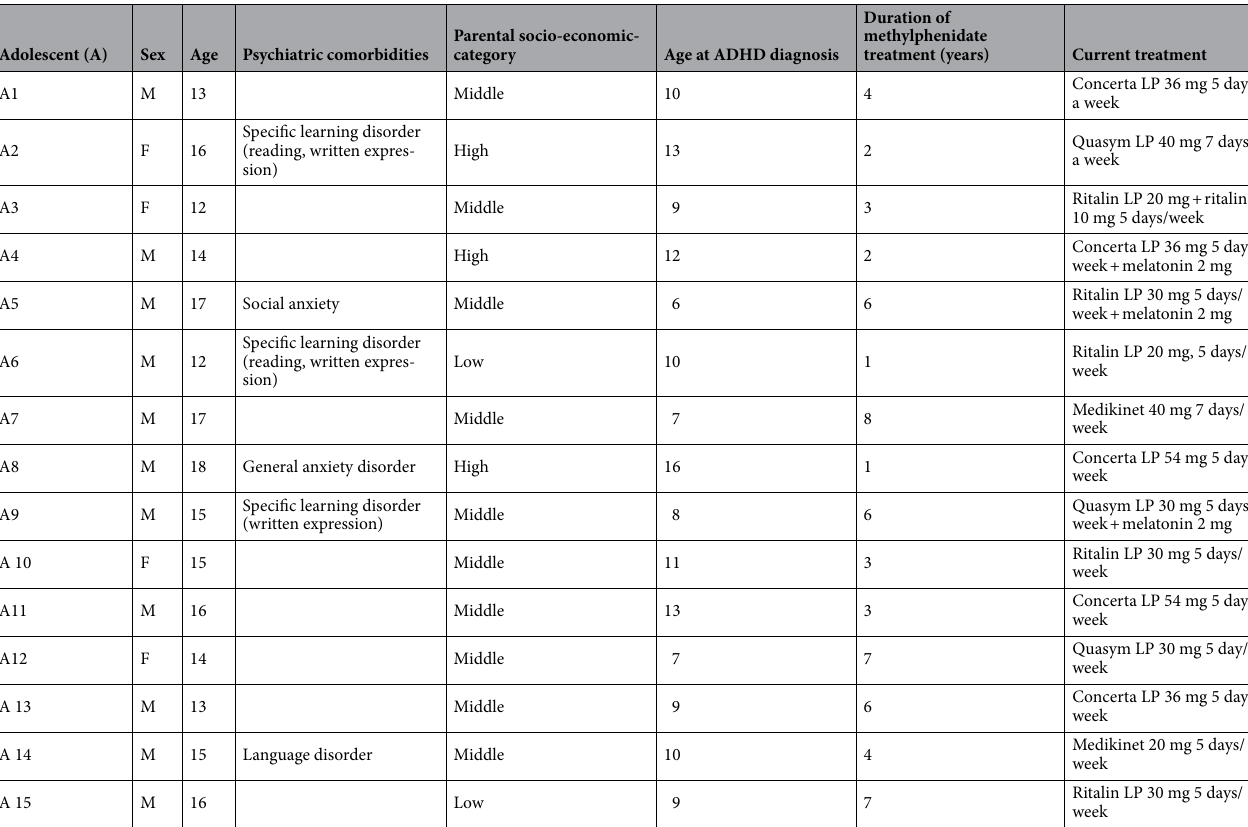
Table 3. Adolescents’